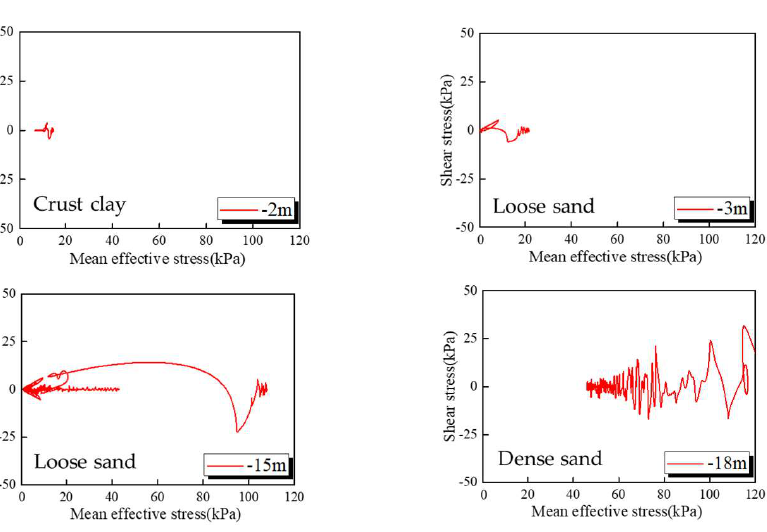
Figure 6. Shear stress–strain curves under the Kobe motion.